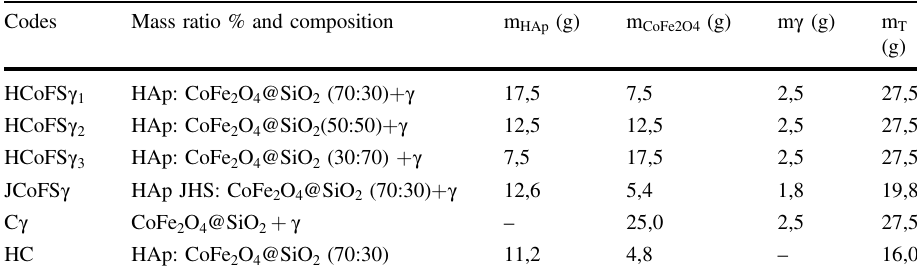
Table 1 List of biomaterials, expressed in symbology and mass ratio